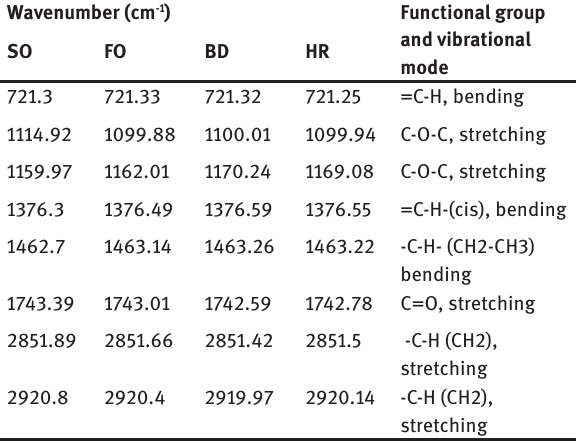
Table 3: Functional group and vibration mode on beef fat based on